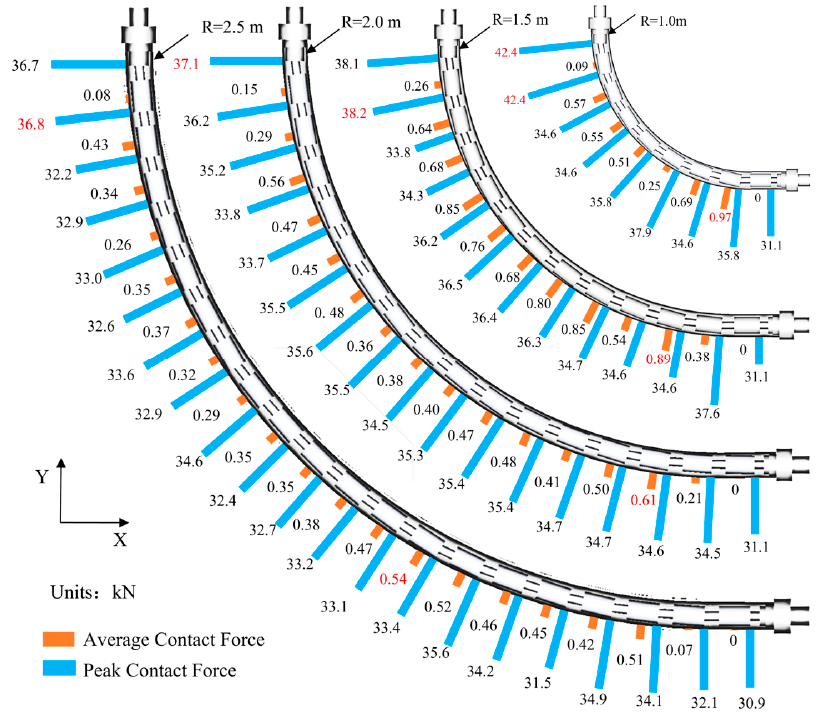
Figure 16. Distribution of flexible drill pipe contact force with different borehole radii.